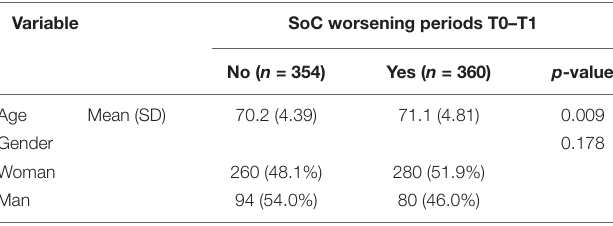
TABLE 3 | Socio-demographic characteristics and SoC worsening between periods T0 and T1: Bivariate analysis. Variable